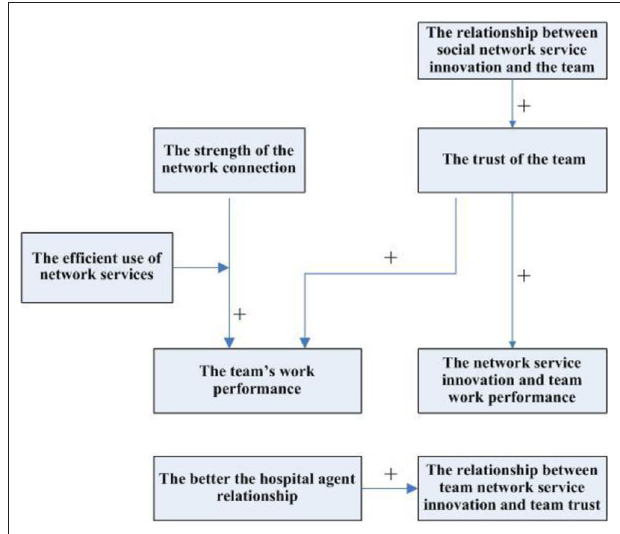
FIGURE 1 | Relationship model between main